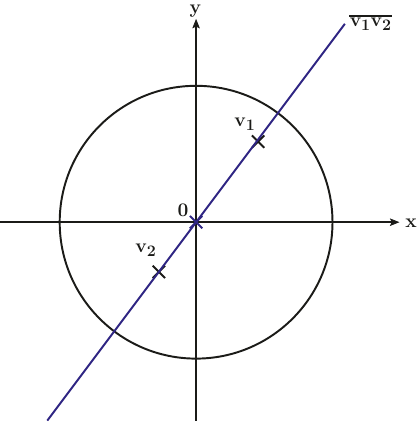
Figure 4 . Graphical illustration of two-point partial fractioning. The origin lies on the line v 1 v 2 , we can use ∆ k ( 0 ) to split ∆ k ( v 1 ) and ∆ k ( v 2 )